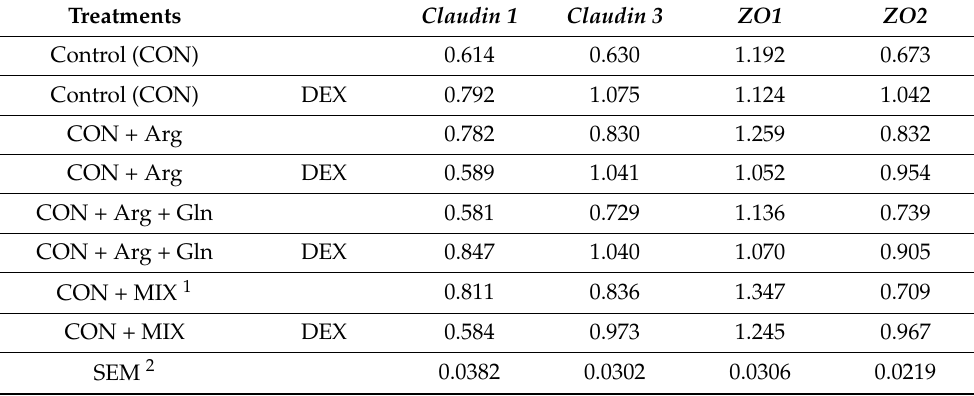
Table 7. Relative gene expression of tight junction proteins in ileum of broilers (day 21) subjected to dexamethasone (DEX) or sham injections (experiment